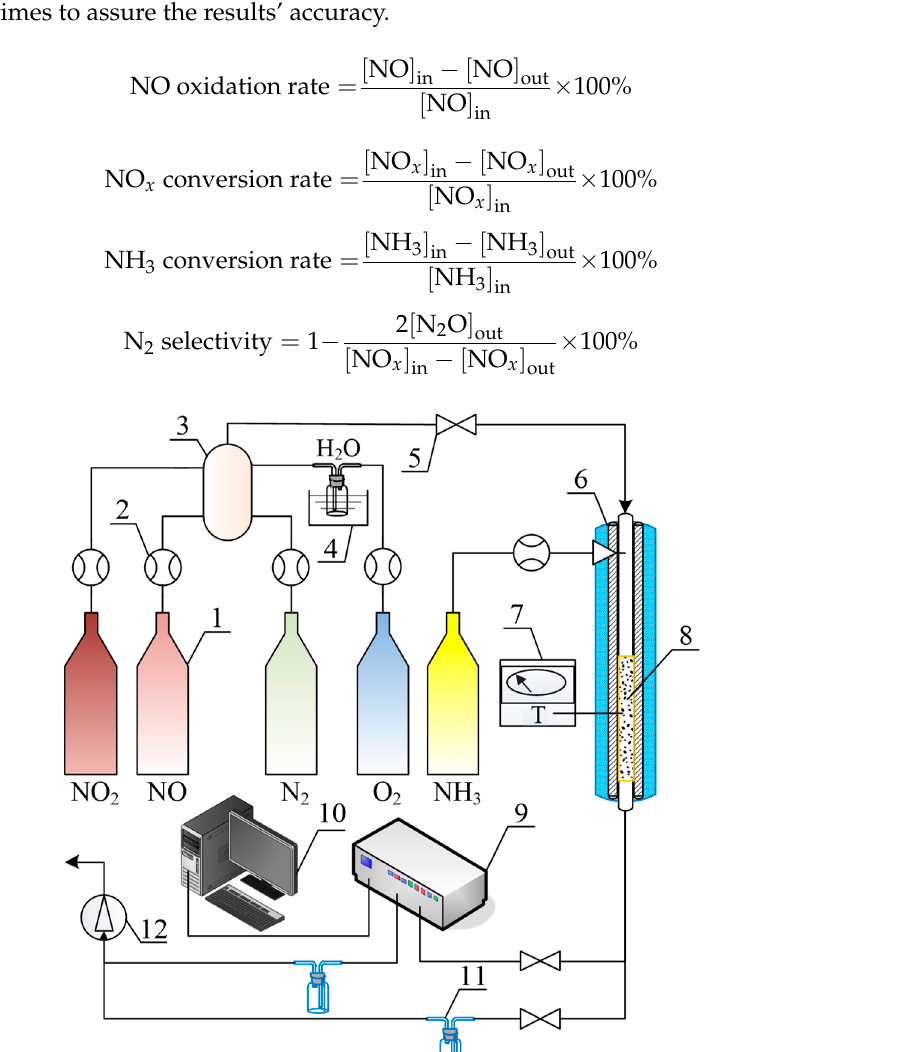
Figure 11. The schematic diagrams of the catalytic performance tests. 1, standard gas; 2, mass flowmeter; 3, gas mixer; 4, water carrier; 5, shutdown valve; 6, resistance furnace; 7, temperature controller; 8, catalysts; 9, flue gas analyzer; 10, record system; 11, gas washing bottle; 12, induced draft fan.